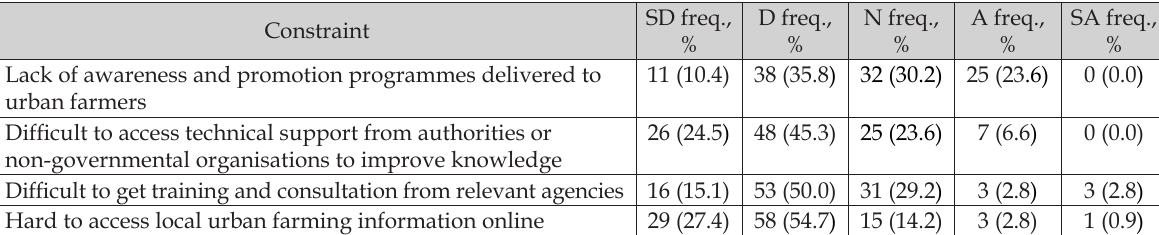
Table 4. Technical